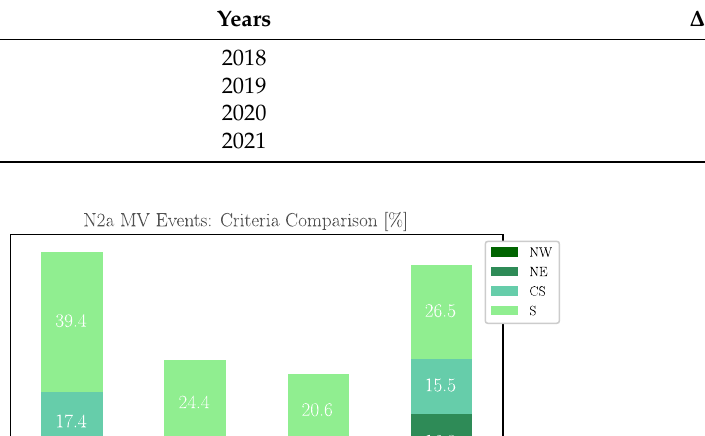
Table 11. N2a percentage variation due to the criterion adopted: MV events.